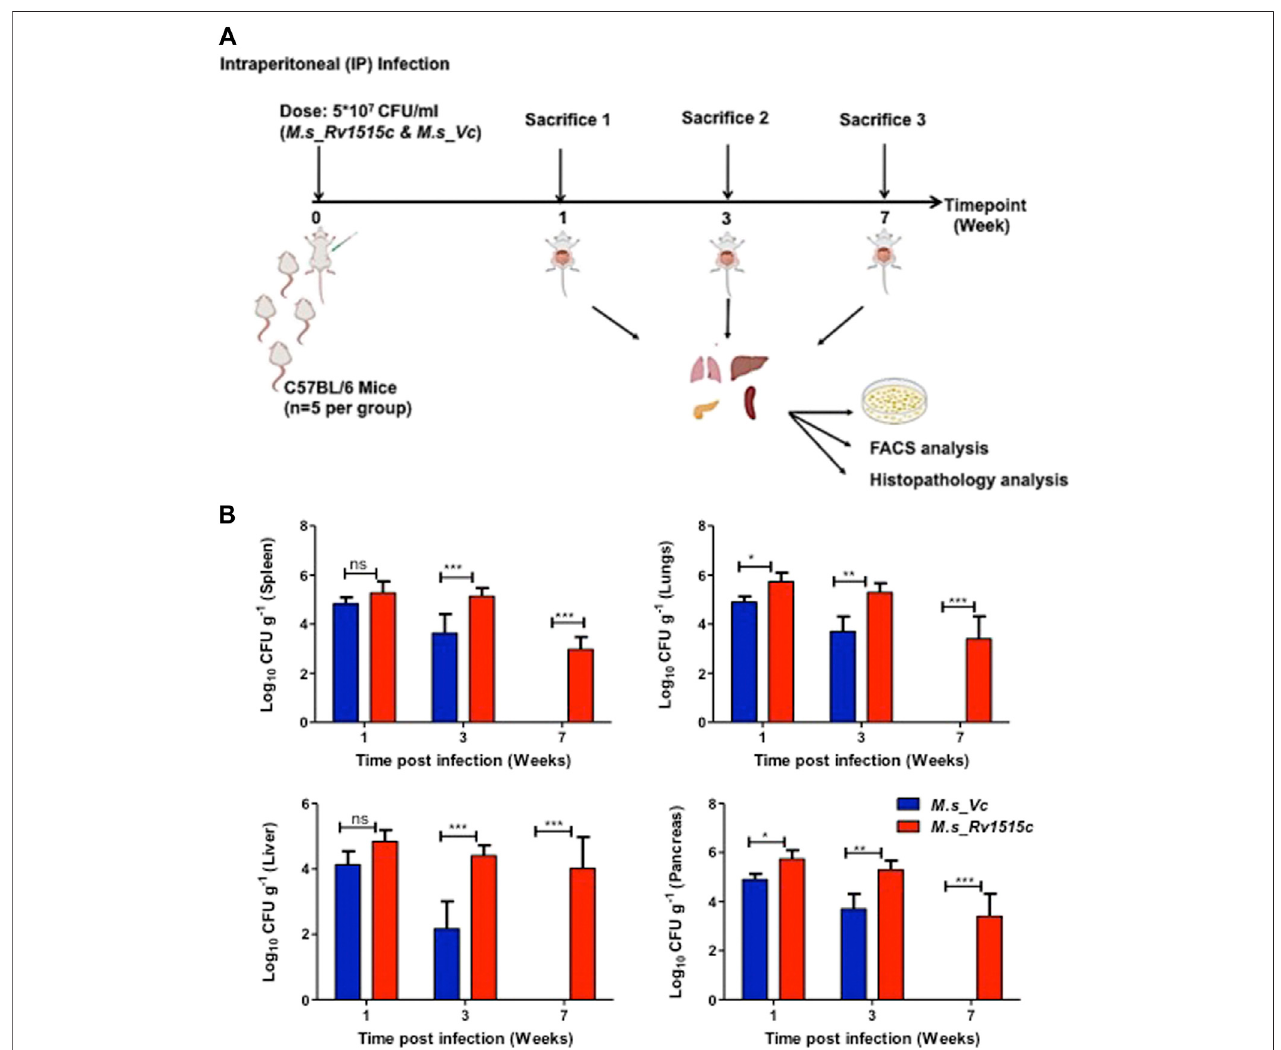
FIGURE7| Recombinant M.smegmatis expressing M.tb Rv1515cpersists invivo . (A) SchematicrepresentationofexperimentstoassesstheeffectofRv1515c in vivo . C57BL/6 female mice ( n = 6) were infected intraperitoneally with M. s _Rv1515c and M. s _Vc. The bacterial loads in the liver, lungs, spleen, and pancreas were determined after 1, 3, and 7 week post-infection. Organs were homogenized and bacterial load was assessed by CFU assay, as described in methods. Single cell suspensionofthelymphnodeorintraperitonealmacrophageswerestainedwithdifferentmarkersforlymphocytesub-populationsandanalysedby fl owcytometry. (B) CFU counts of the M. s _Rv1515c and M. s _Vc that persisted in the spleen, lungs, liver, and pancreas were determined. Data are represented as mean ± SD and analysed using two-way ANOVA followed by Bonferroni test. * p < 0.05, ** p < 0.01, *** p < 0.001, ns- nonsigni fi